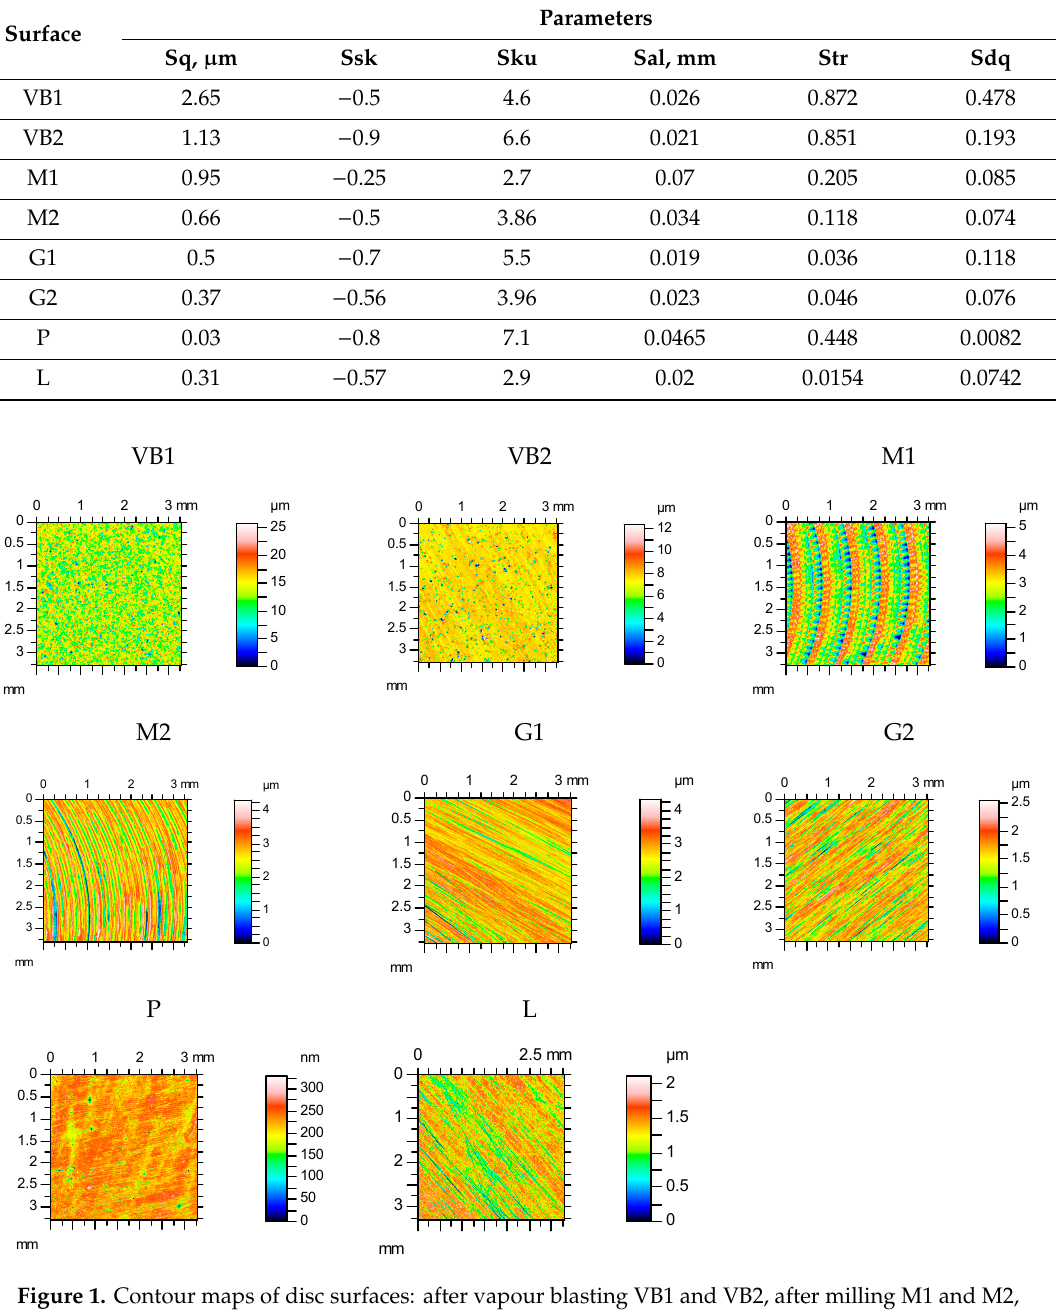
Table 2. Parameters of surface topographies of discs: Sq, Ssk, Sku, Sal, Str and Sdq before fretting tests.